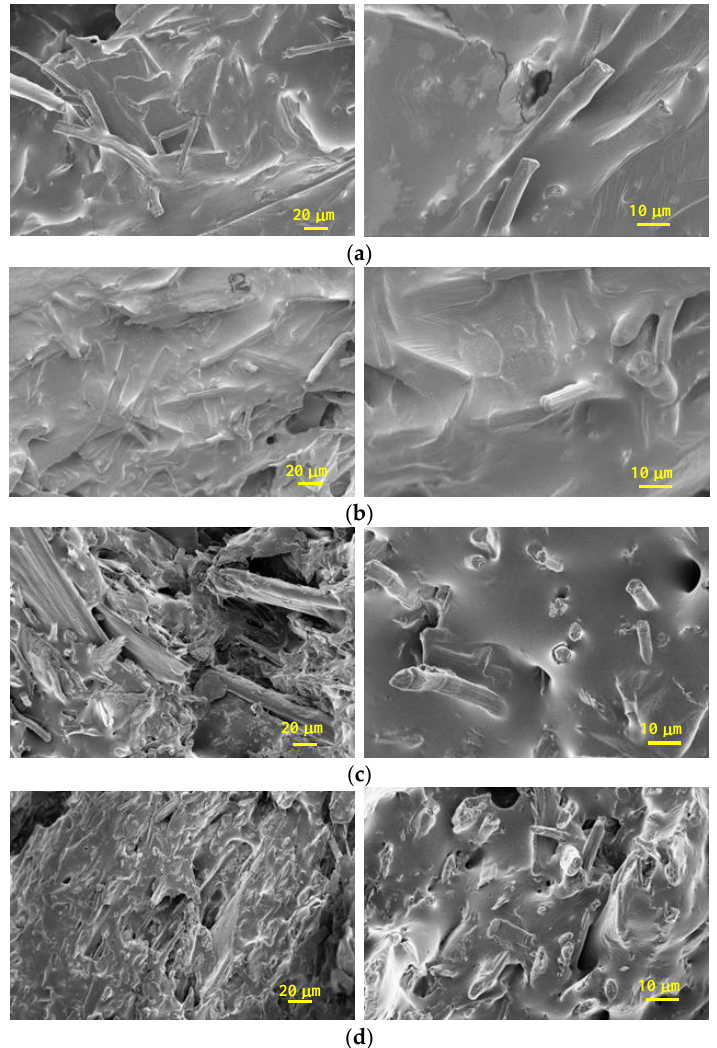
Figure 11. Field Emission Scanning Electron Microscope (FESEM) images of ( a ) TPUU-SS + 40 wt % CF; ( b ) TPUU-SS + 60 wt % CF; ( c ) TPUU + 40 wt % CF and ( d ) TPUU + 60 wt % CF.